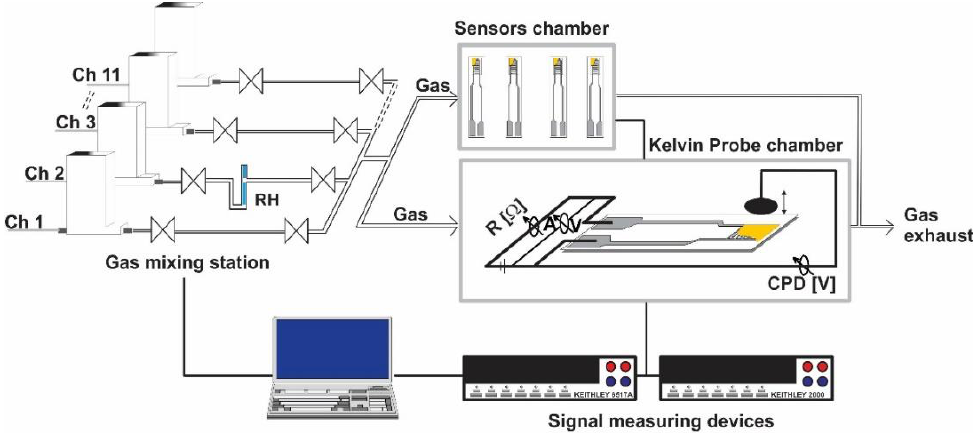
Figure 1. GMS with accessories for phenomenological evaluation of the gas sensing properties.